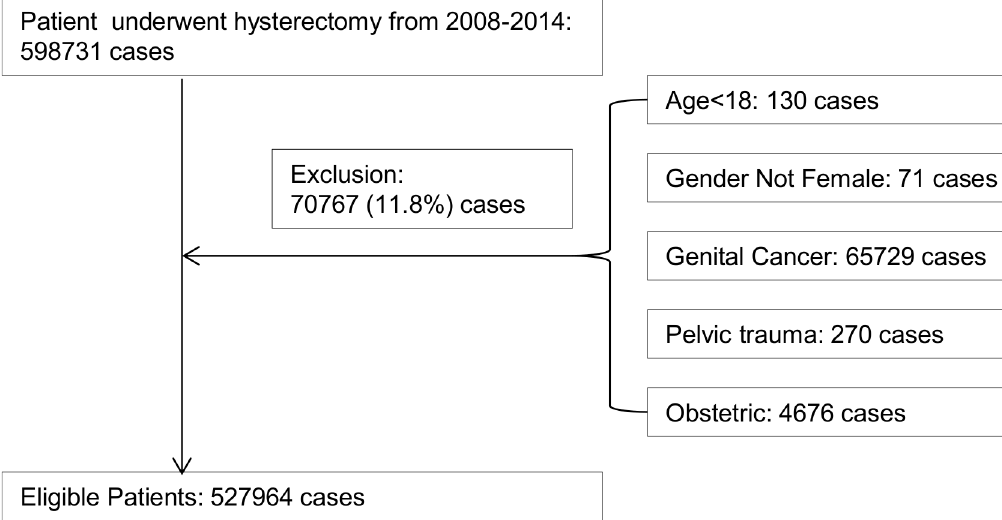
Fig 1. Flow chart of study sample inclusion and exclusion